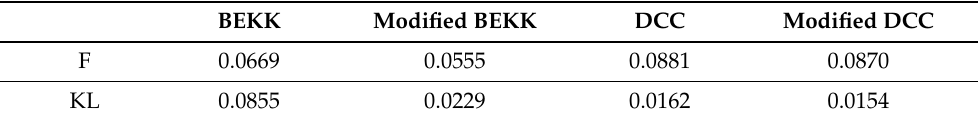
Table 2. Values of the Frobenius and the Kullback–Leibler loss functions: case N = 5 and δ = 0.5.